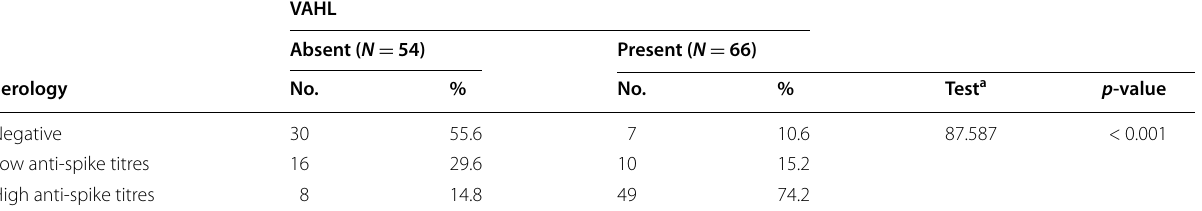
Categorical variables were expressed as number (percentage) a Chi-square test; p < 0.05 is